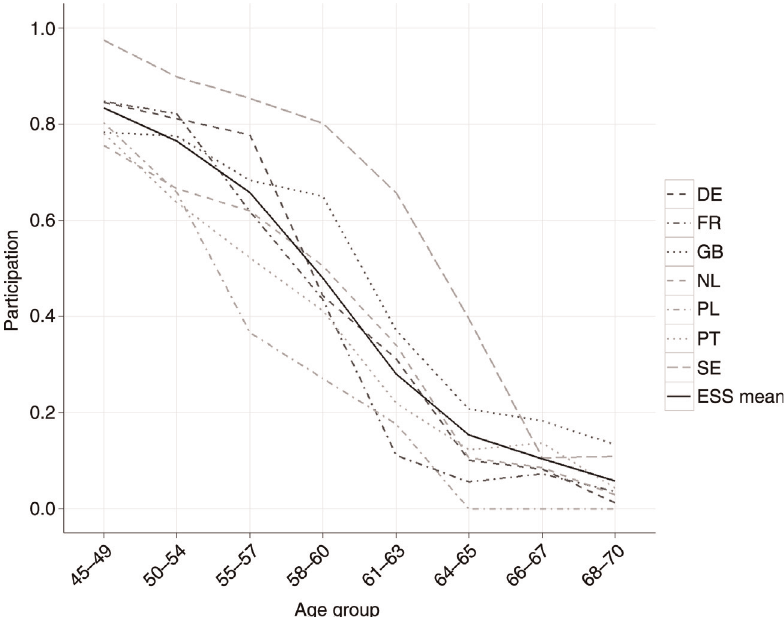
Figure 2. Labor market participation of workers aged 45 (cid:2) 70 in se v en European countries and the a v erage ESS participation. ESS 2004,